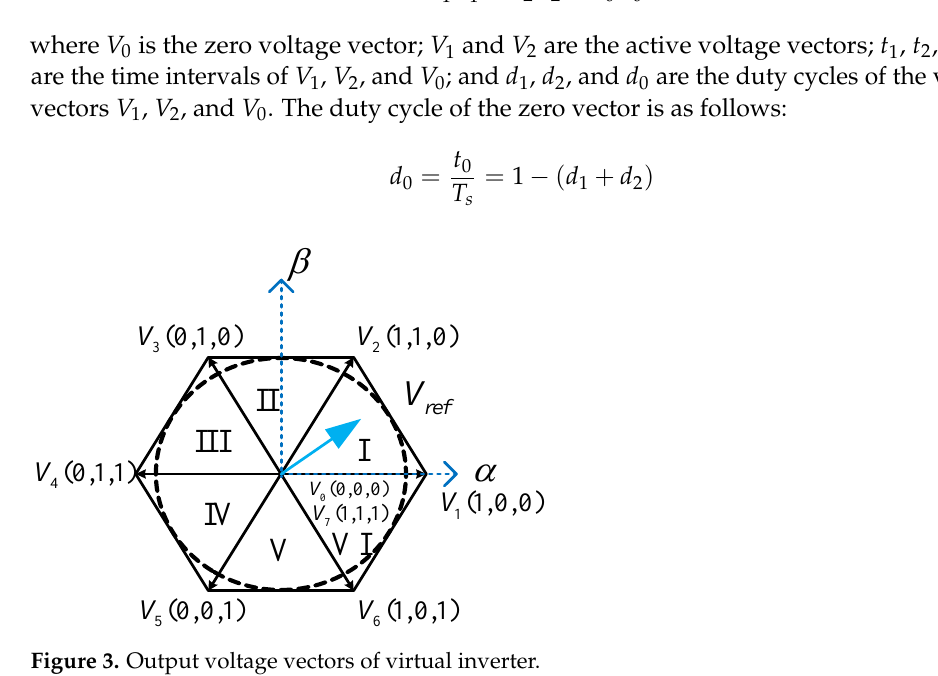
Figure 3. Output voltage vectors of virtual inverter.